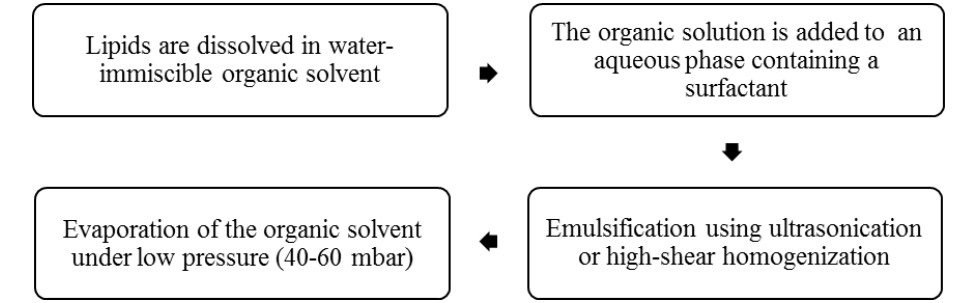
Figure 4. Preparation of NLCs by solvent emulsification/evaporation technique.